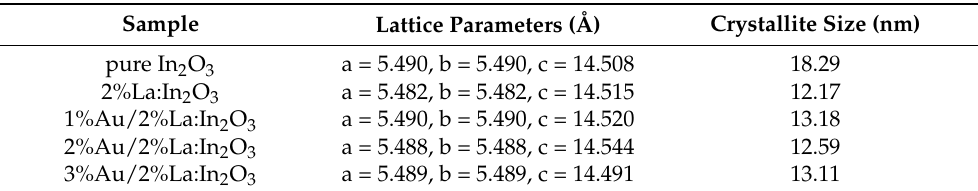
Figure 1. XRD patterns of the pure In 2 O 3 , 2 mol%La-In 2 O 3 and x mol%Au/La-In 2 O 3 (x = 1, 2, 3) samples. Table 1. Lattice parameters and crystallite size of pure In 2 O 3 , 2 mol% La-In 2 O 3 and x mol% Au/La- In 2 O 3 (x = 1, 2,